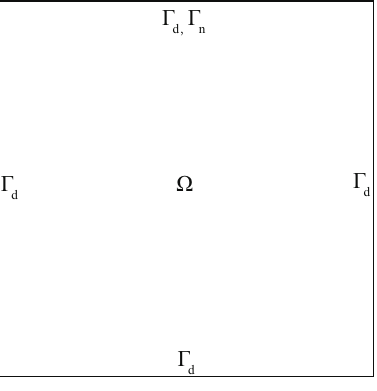
Figure 7. Figure 8. B.C. V Figure 7. B.C. IV.